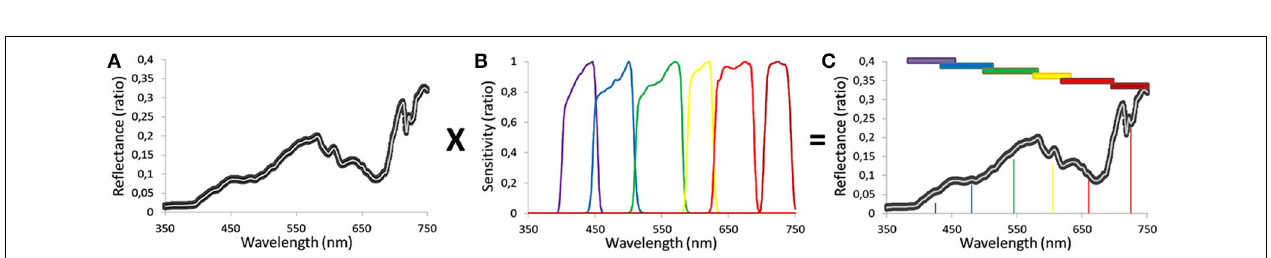
reflectance of the “red edge” is here represented by a rainbow-scaled gradient (0–0.11). Electro-magnetic radiation akin to the 705–745nm gamut (i.e., spectral range of the “red edge” band) is reflected from benthos as deep as 2m, as revealed by the positive values of the density function values in both islands.